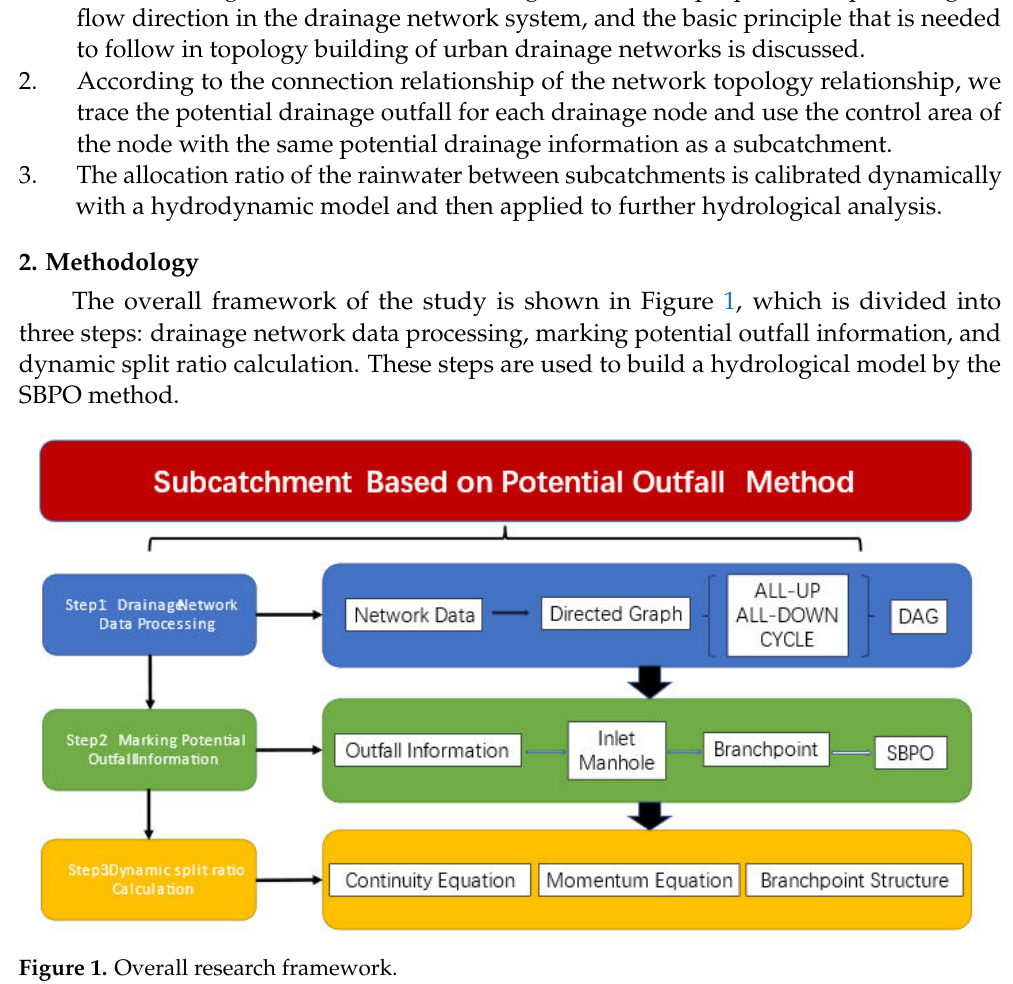
Figure 1. Overall research